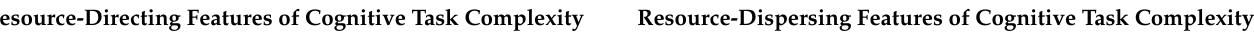
Table 1. Resource-directing and Resource-dispersing Features of Cognitive Task Complexity (Robin- son